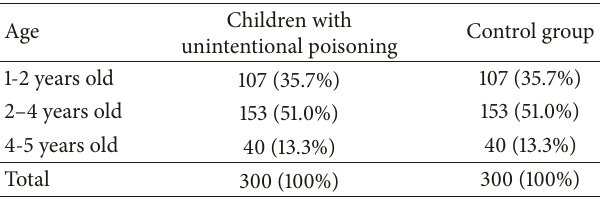
Table 2: Age distributions of two groups: “children with acute unintentional poisoning” and “control group.”